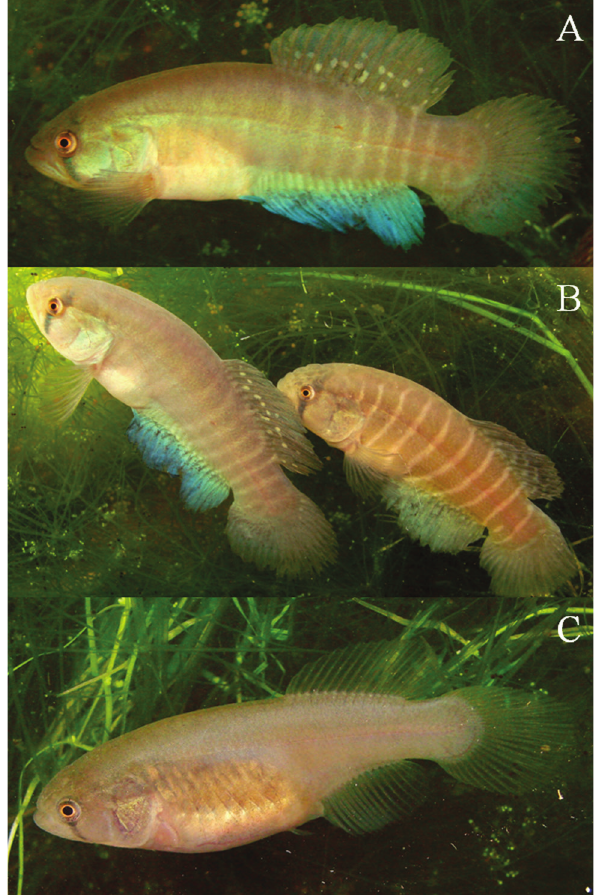
Fig. 1. Austrolebias cheradophilus sampled in Jaguarão Riv- er, Patos-Mirim Lagoon system, southern Brazil: (A) Male, 49.2 mm SL, (B) variation in color pattern of males (41.3 mm and 49.2 mm SL) and (C) female, 41.2 mm SL. Photos by Matheus